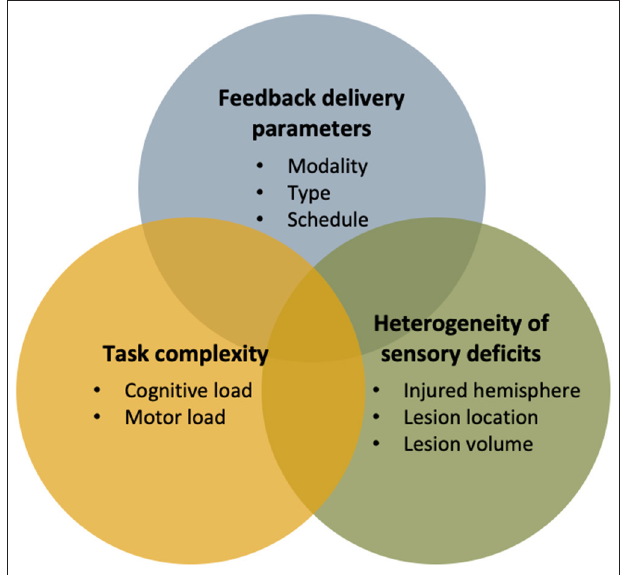
FIGURE 3 | Summary of important factors to consider when designing a multimodal feedback approach in technology-based interventions for sensorimotor